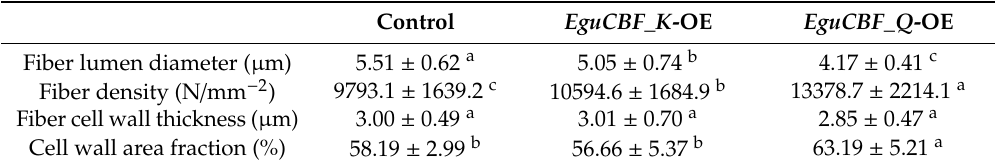
Table 2. Properties of xylem fibers in Eucalyptus CBF -overexpressors.